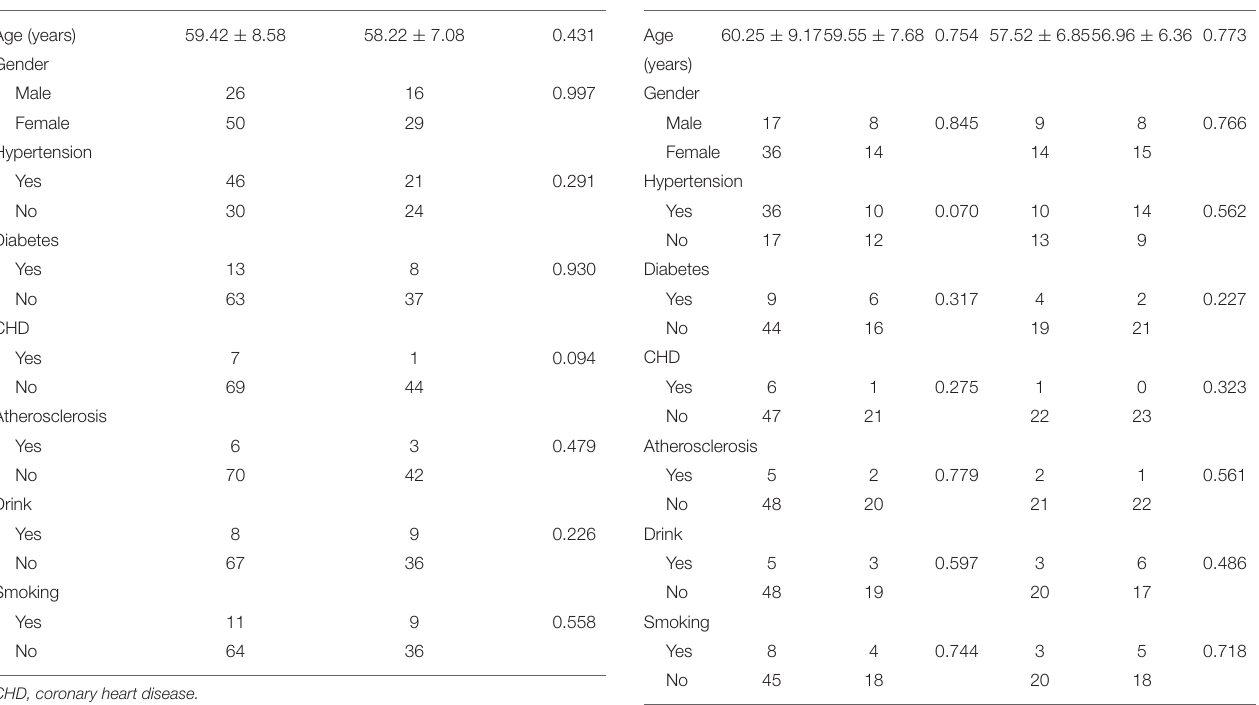
TABLE 1 | Clinical characteristics of RIAs and UIAs. TABLE 2 | Clinical characteristics of RWNAs and UWNAs, RNNAs and UNNAs. Variable RWNAs UWNAs P -value RNNAs UNNAs P -value